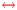
For 2015 epidemiology weeks 1–52, the incidence rate (IR) per 100,000 population in 3 sites: Z-5, Z-7L and Z-14.In all 3 sites routine operational vector control activities were conducted. However, the direct Bti application into containers and wide area Bti spray treatment were integrated in the routine control activities in site Z-7L on weekly interval from EW 24–27 (↔) and fornightly interval from EW 28–35 (←⋅→).